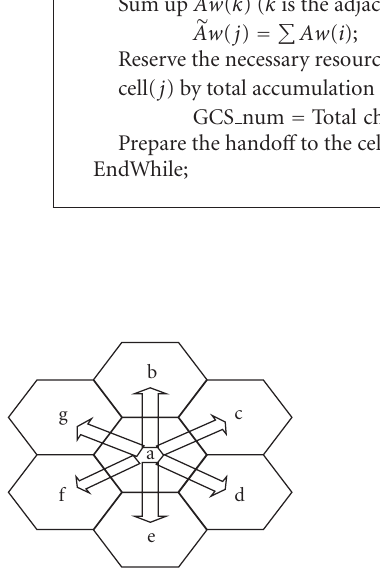
Figure 1: Possible cells of hando ff